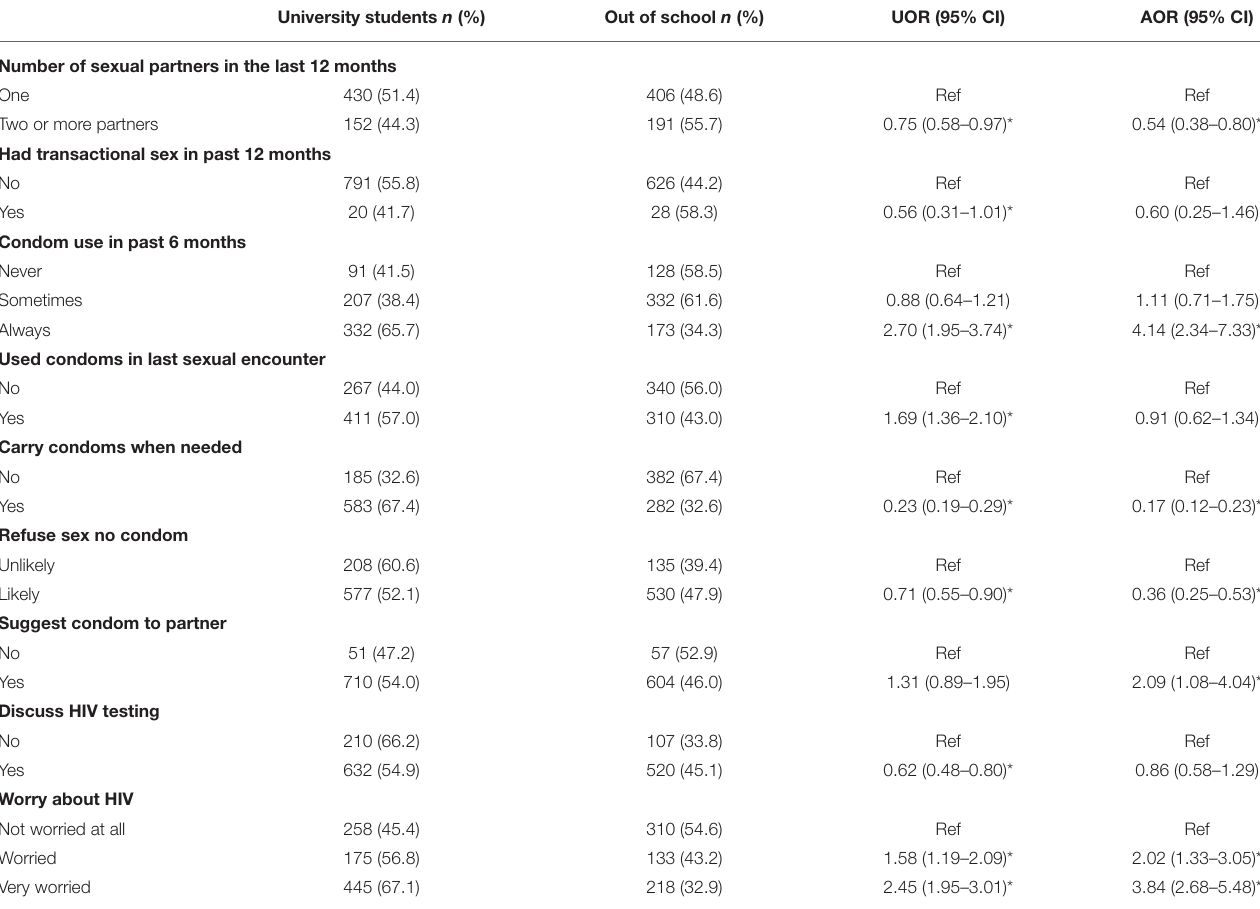
TABLE 4 | Bivariate and multivariable logistic regression analysis of sexual behaviors associated with the group